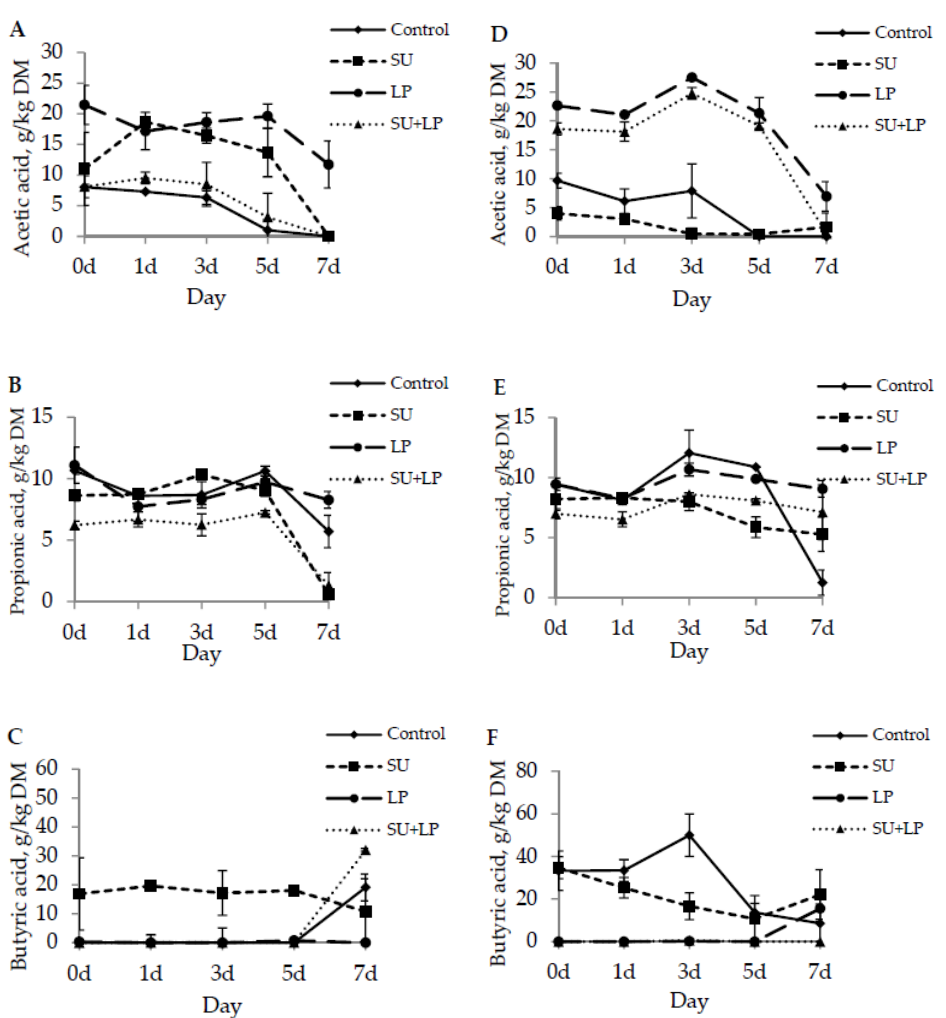
Figure 4. Dynamic changes in the acetic acid content during aerobic exposure of L . chinensis silage with di ff erent additives at 1–2 cm length ( A ) and 4–5 cm length ( D ). Dynamic changes in the propionic acid content during aerobic exposure of L . chinensis silage with di ff erent additives at 1–2 cm length ( B ) and 4–5 cm length ( E ). The dynamic changes in the butyric acid content during aerobic exposure of L . chinensis silage with di ff erent additives at 1–2 cm length ( C ) and 4–5 cm length ( F ). SU, sucrose; LP, Lactobacillus plantarum ; DM, dry matter .